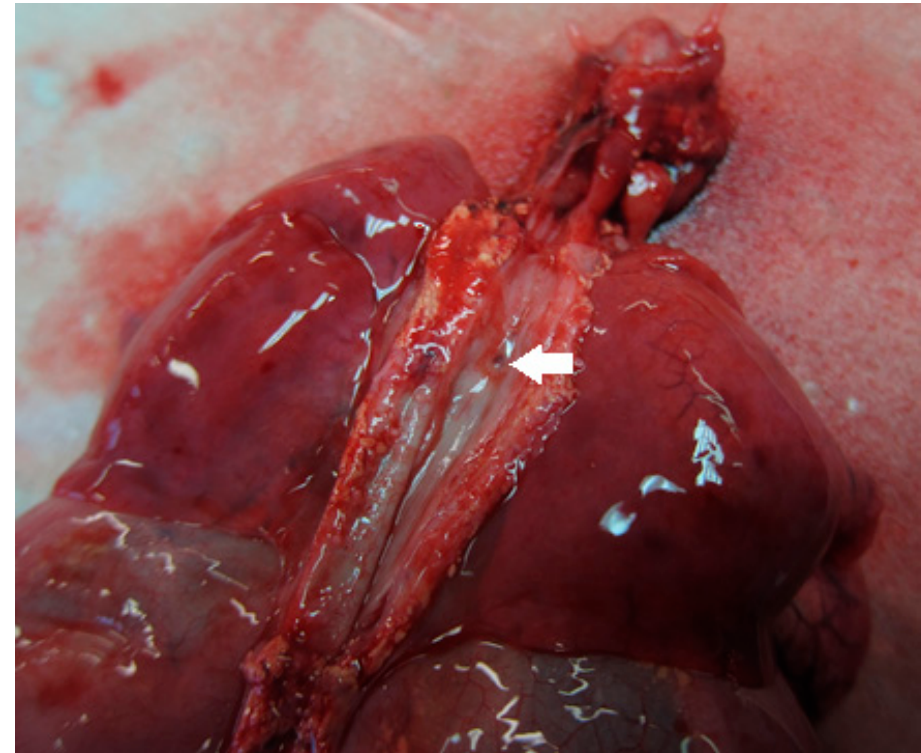
Figure 5. Postmortem specimen including the esophagus, lungs, and larynx. The esophagus is sectioned posteriorly on the midline: carinoesophageal fistula ( white arrow ).